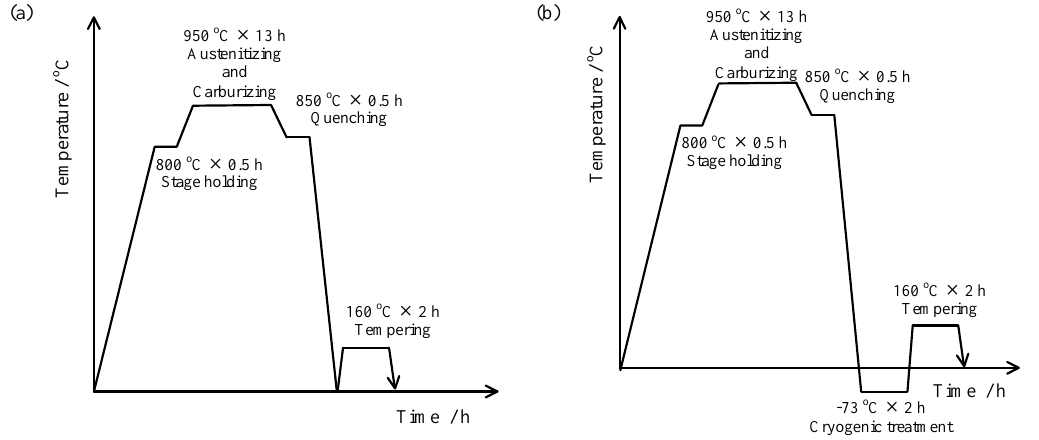
Figure 2. Schematic diagram of the carburizing heat treatment process of the 18Cr2Ni4WA steel: ( a ) process 1: quenching + tempering; ( b ) process 2: quenching + cryogenic treatment +